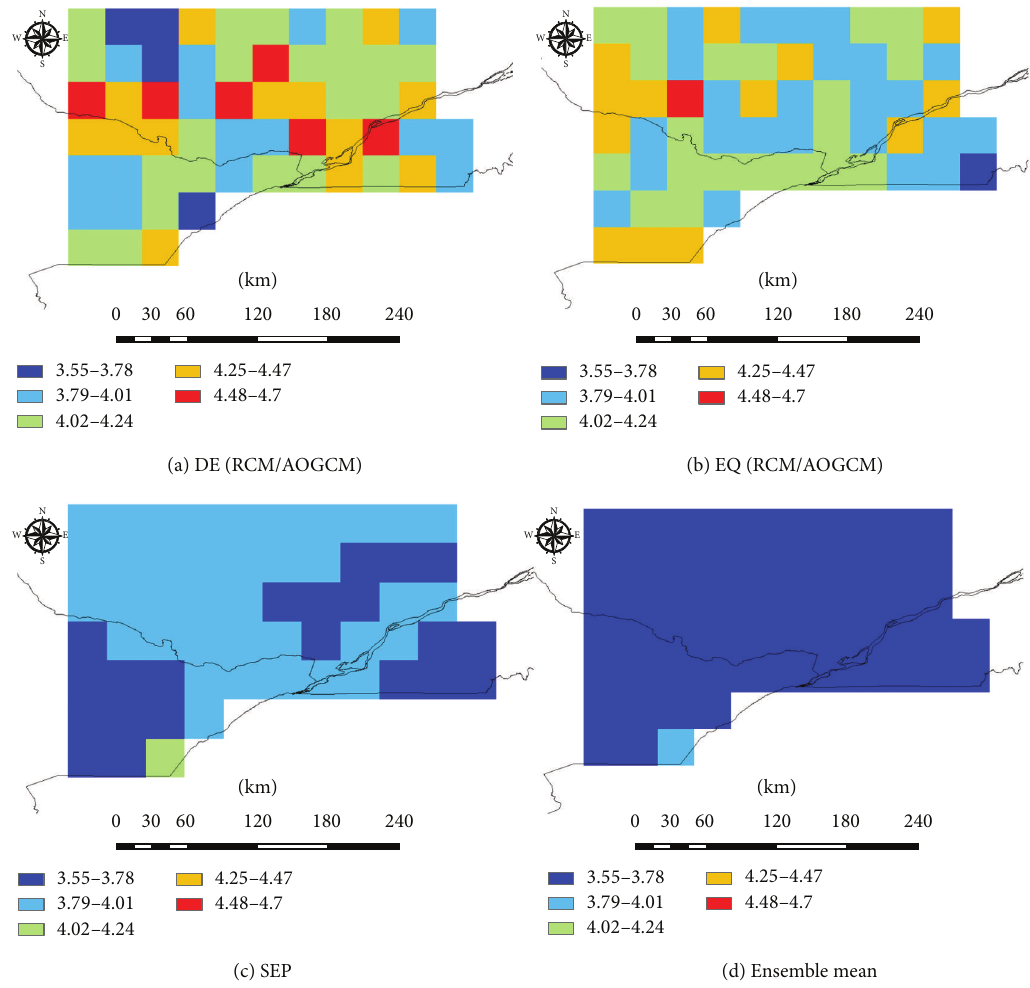
Figure 9: Climate change signal of the 10th percentile values at all grid points within the study area for 𝑇 max from DE (RCM/AOGCM), EQ (RCM/AOGCM), SEP, and the ensemble